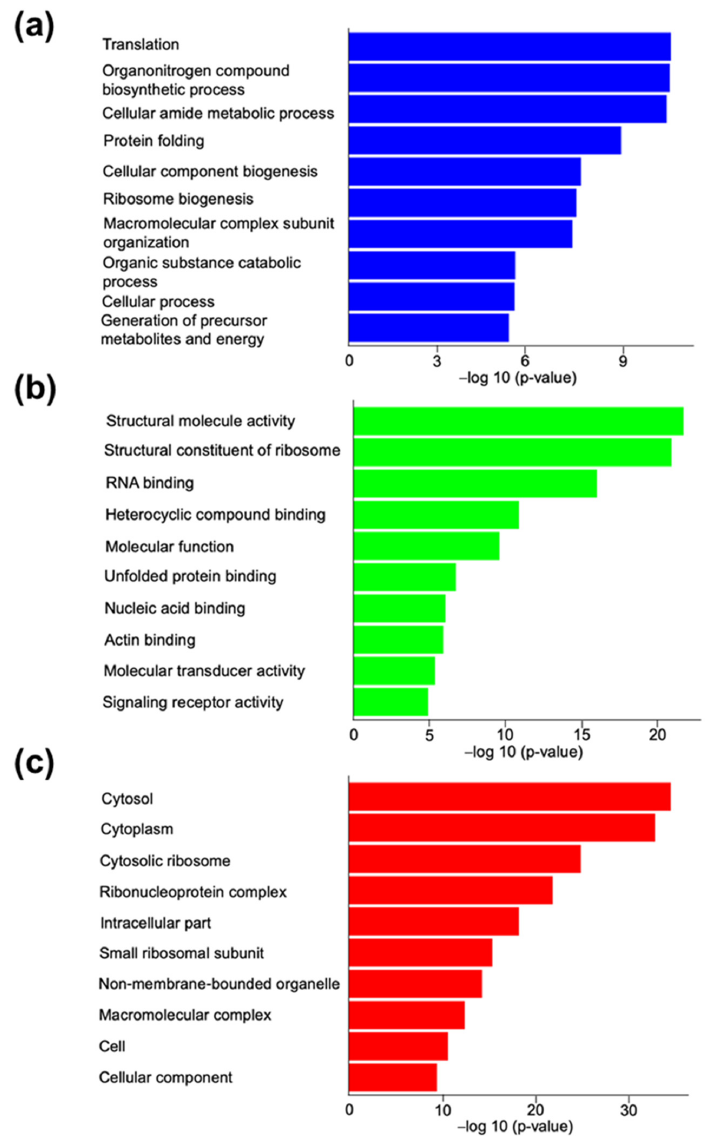
Figure 3. Parental Gene Ontology terms from a proteomic analysis for canine in vitro oviductal cell-derived extracellular vesicles. The top ten ( a ) biological processes, ( b ) molecular functions, and ( c ) cellular components are overrepresented using the list of 398 common proteins identified in three biological samples of canine in vitro oviductal cell-derived extracellular vesicles. The GO analysis highlighted the physiological relevance of the OC-EVs proteins in the metabolism. In addition, the overrepresentation analysis by PANTHER identified sev- eral metabolic pathways, such as the tricarboxylic acid cycle, pentose phosphate pathway, and ATP synthesis (Table S4G). The classes of proteins defined by PANTHER with the highest fold enrichment were hydratase, Hsp90 family chaperone, and chaperonin (Table S4H).